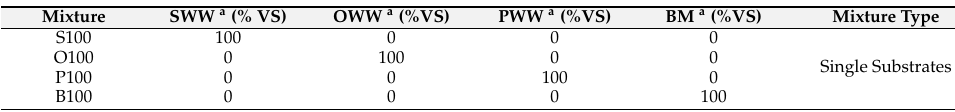
Figure 1. Simplex-lattice mixture design tested for anaerobic co-digestion (AcoD) of slaughter- wastewater) and bovine manure (BM). Table 3. Mixture design applied in the evaluation of